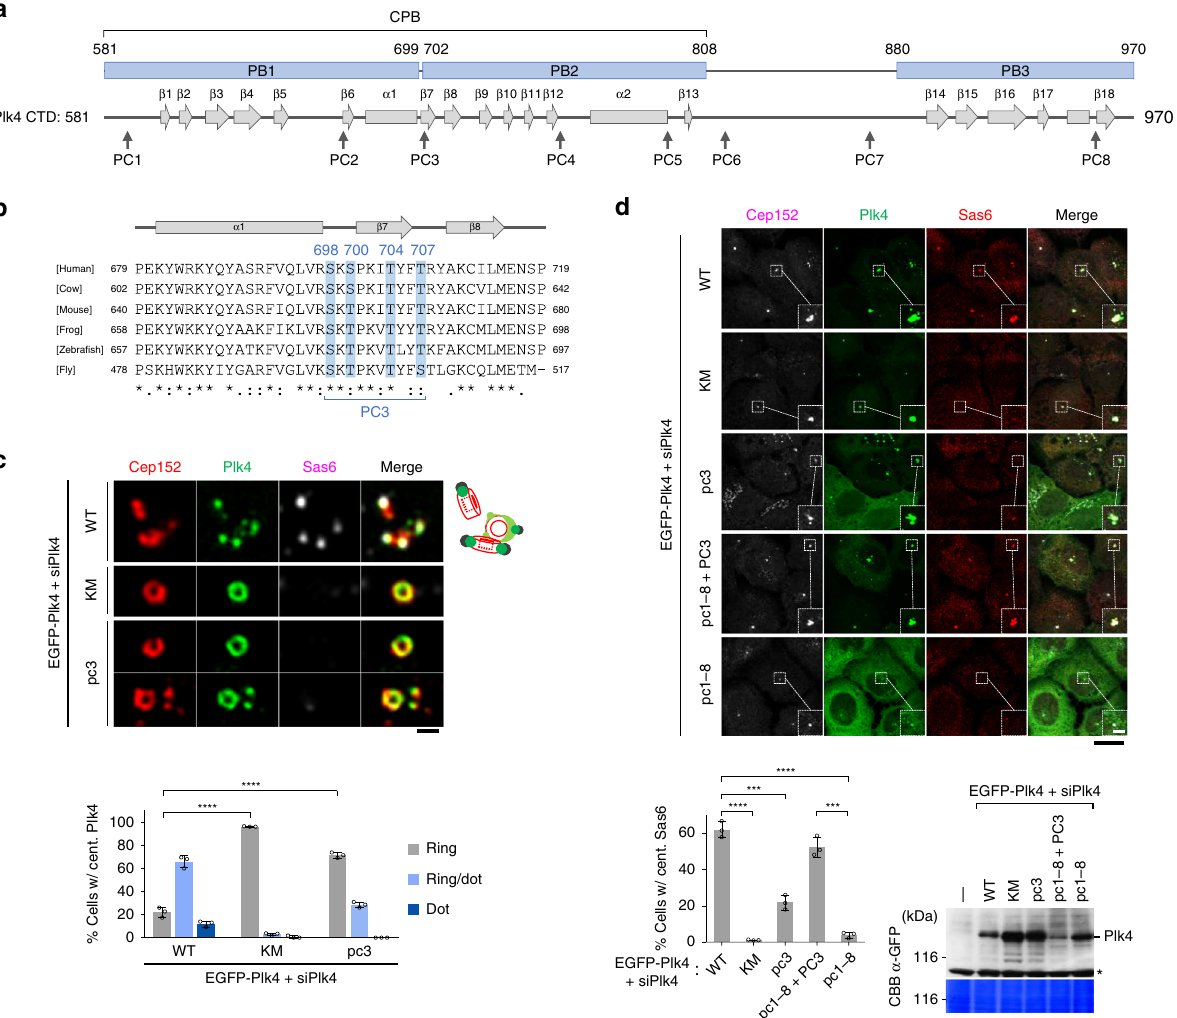
Fig. 1 Plk4 triggers its symmetry-breaking ring-state-to-dot-state relocalization by autophosphorylating its CPB. a Schematic diagram showing the secondary structure of the Plk4 CTD. Numbers indicate amino acid residues. The positions of PC1 to PC8 are marked. b Multiple sequence alignment for the region containing PC3 was performed using the Clustal Omega software. The S698, S700, T704, and T707 residues phosphorylated in vivo are indicated. c 3D-SIM analysis of immunostained U2OS cells stably expressing the indicated EGFP-Plk4 constructs and silenced for endogenous Plk4 (siPlk4). The schematic diagram (right) illustrates multiple Cep152 ring (red), Plk4 dot (green), and Sas6 (black) signals. Bar, 0.5 μ m. Quanti fi cation of images is shown in mean ± s.d. ( n = 3 independent experiments). Note that like the catalytically inactive Plk4 KM mutant, the pc3 mutant remained at a ring state. **** P < 0.0001 (unpaired two-tailed t test). d Confocal analysis of immunostained U2OS cells stably expressing various EGFP-Plk4 constructs under Plk4 RNAi conditions (siPlk4). Bar, 20 μ m. Dotted boxes, areas of image enlargement (bar, 3 μ m). Quanti fi ed data are shown in mean ± s.d. ( n = 3 independent experiments). Immunoblotting shows the expression of each construct. *** P < 0.001; **** P < 0.0001 (unpaired two-tailed t test). Asterisk denotes a cross-reacting protein. CBB, Coomassie Brilliant Blue-stained membrane. Source data are provided as a Source Data fi le for c ,